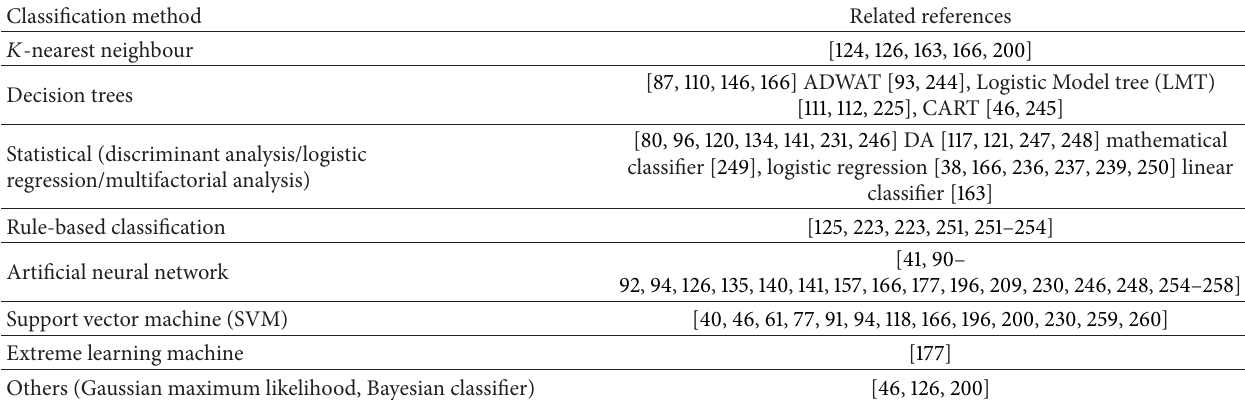
Table 4: Classification methods used in the literature for skin cancer